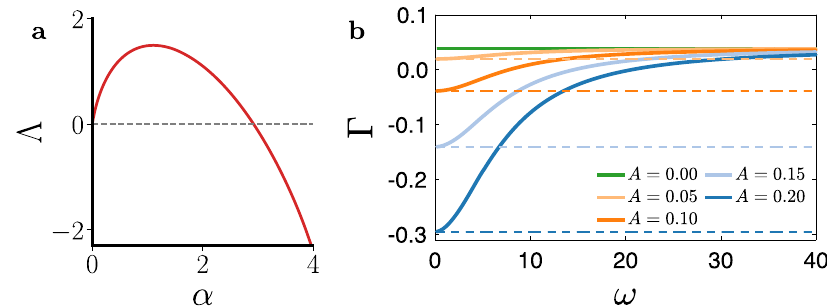
Fig. 3 Temporal networks enable synchronization among Stuart – Landau oscillators. a Master stability function for Stuart – Landau oscillators. Parameters are set to c 1 = − 1.8 and c 2 = 4. b Maximum Lyapunov exponent Γ as a function of the switching rate ω for different values of the temporal activity A (solid lines). The dashed lines indicate the slow-switching limit predicted by the averaged master stability function Λ